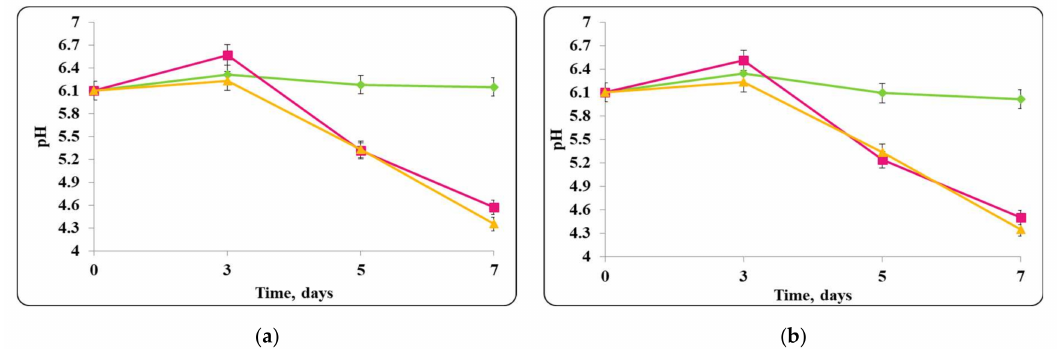
Figure 15. ( a ) free lactobacilli cells; ( b ) encapsulated lactobacilli cells. Changes in the total titratable acidity of MRS broth inoculated with Lb. helveticus 2/20 and S. aureus ATTC 25923 during storage at 4 ± 2 ◦ C. Legend: Green (cid:117) : TA of MRS broth inoculated with Lb. helveticus 2/20; Pink (cid:4) : TA of MRS broth co-inoculated with Lb. helveticus 2/20 and S. aureus ATCC 25923; Yellow (cid:78) : TA of MRS broth inoculated with S. aureus ATCC 25923.